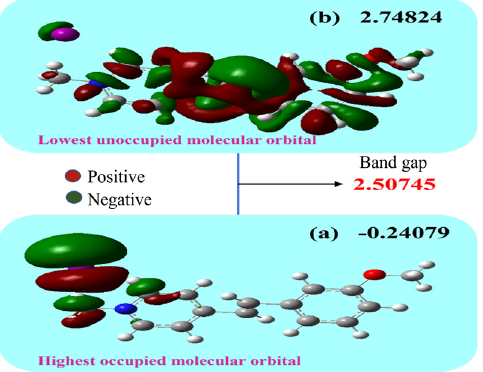
Figure 15. ( a , b ) Molecular orbital HOMO and LUMO diagram of